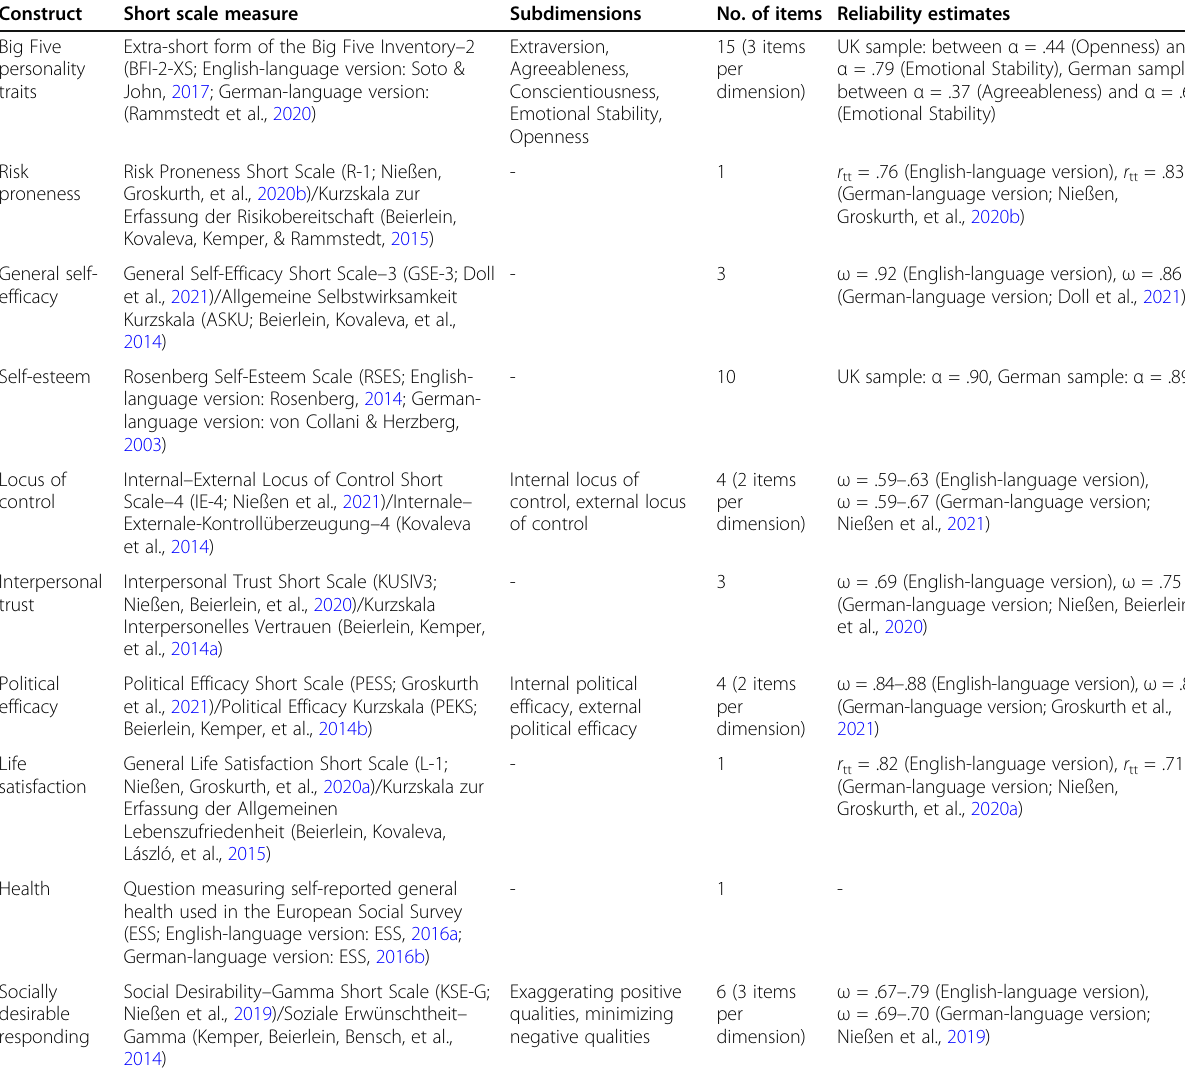
Table 3 Short-scale measures used in the survey correlated with SOP2